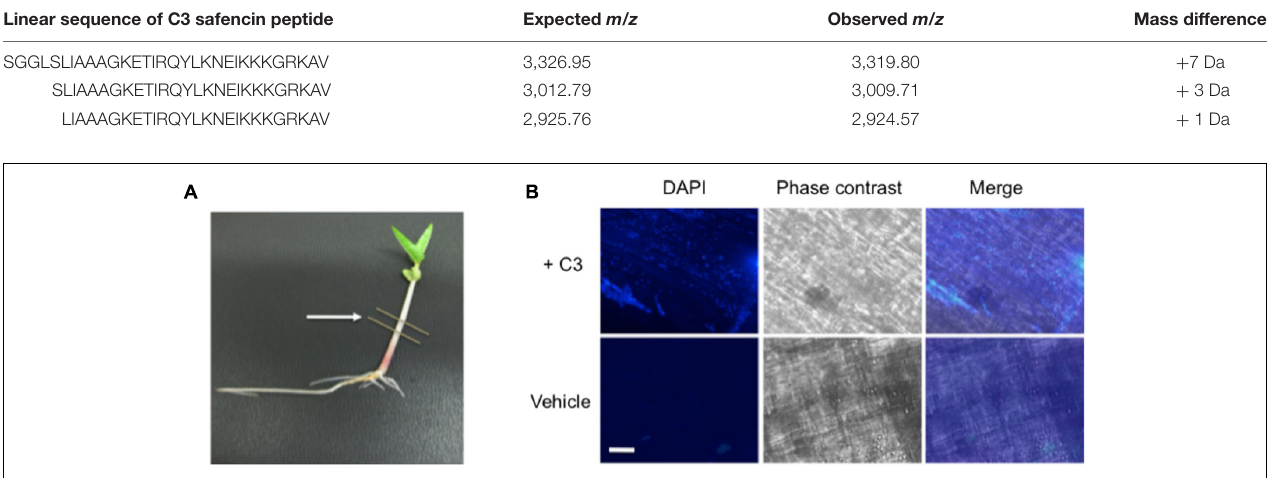
FIGURE 6 | Microscopic images of C3 detection in bacteria inoculated seeds. (A) Following inoculation, V. radiata plants were placed directly under specific light conditions and grown for 7 days prior to processing, with young plants reaching an average height of 4–6 cm. Single plants were placed onto sterile plates for dissection. Lines indicate area removed for dissection and processing. Cuttings were directly placed onto glass slides and incubated with DAPI for visualization of bacteria. (B) 40 × microscopic images show C3 bacilli colonized on plant cells (top panels). Plants treated with vehicle control show little bacteria compared with C3 inoculated samples. Plants remained healthy throughout the duration of the experiment. DAPI was used to visualize bacteria, and phase contrast merged images to locate the boundaries of the plant cell. White bar indicates an approximate measurement of 50 µ m in